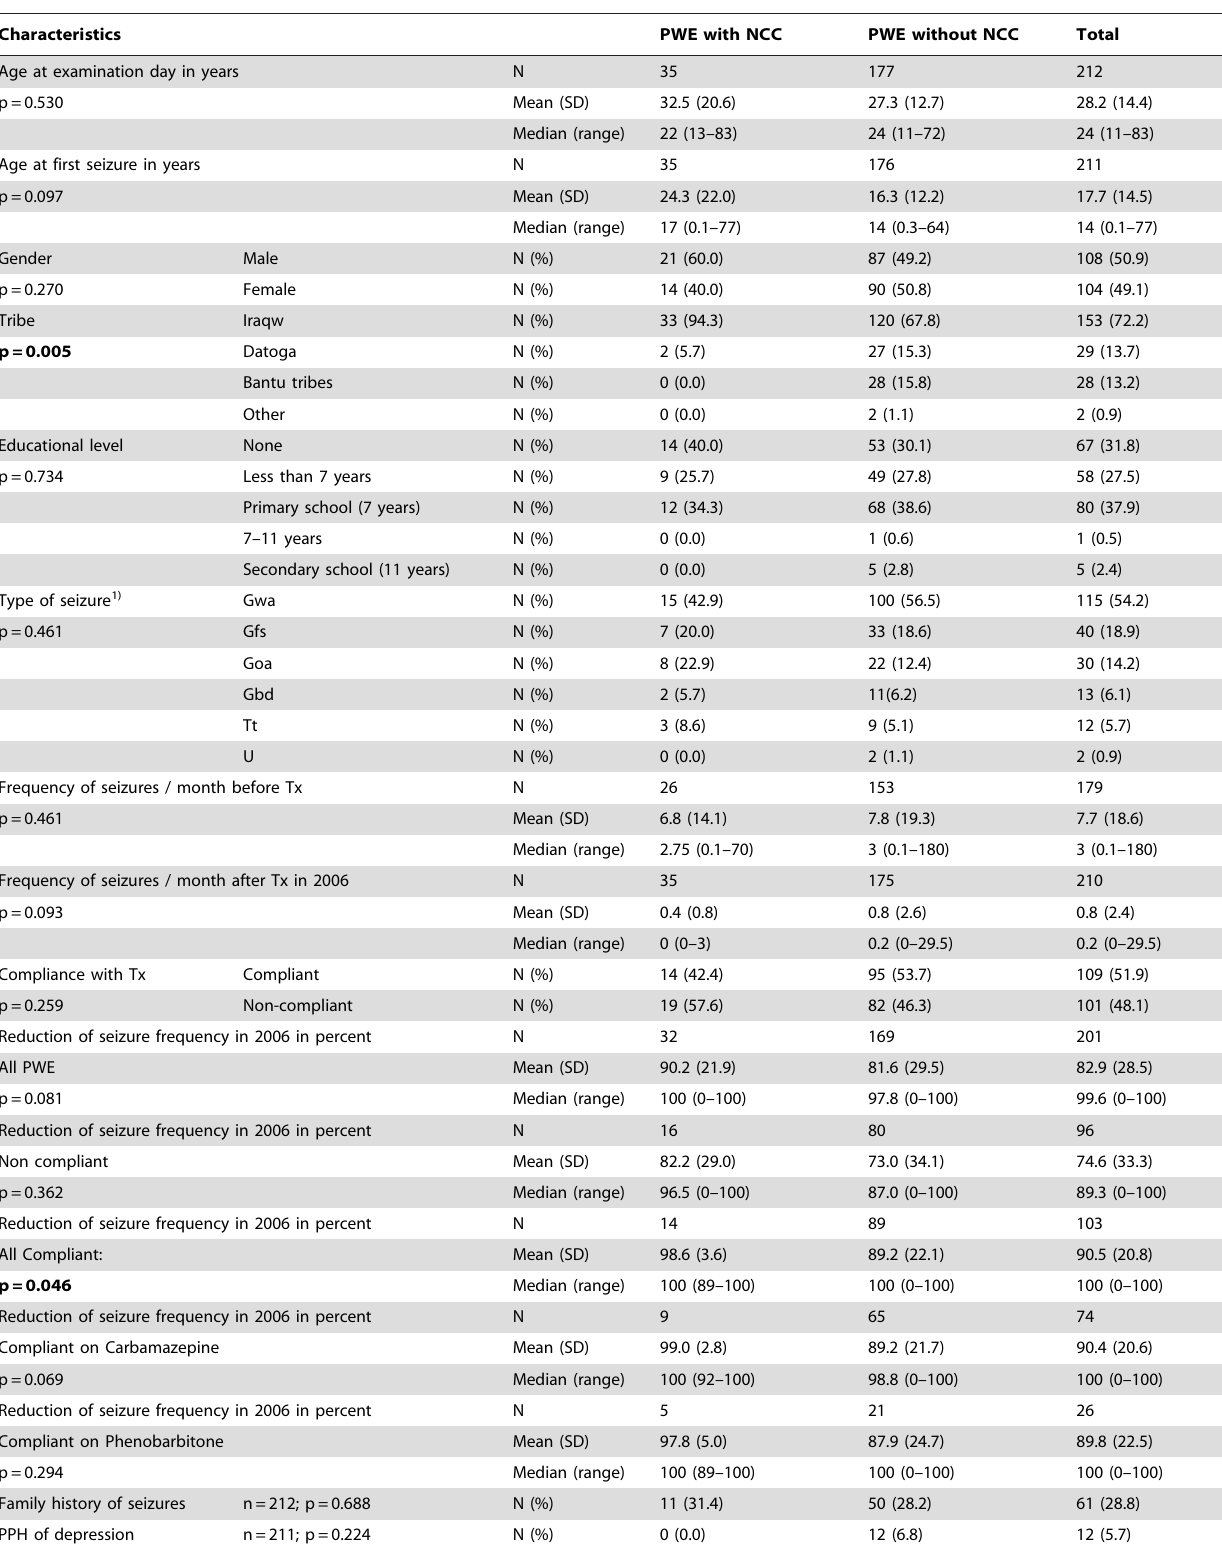
Table 1. Demographic data, clinical characteristics and associated factors of people with epilepsy with and without